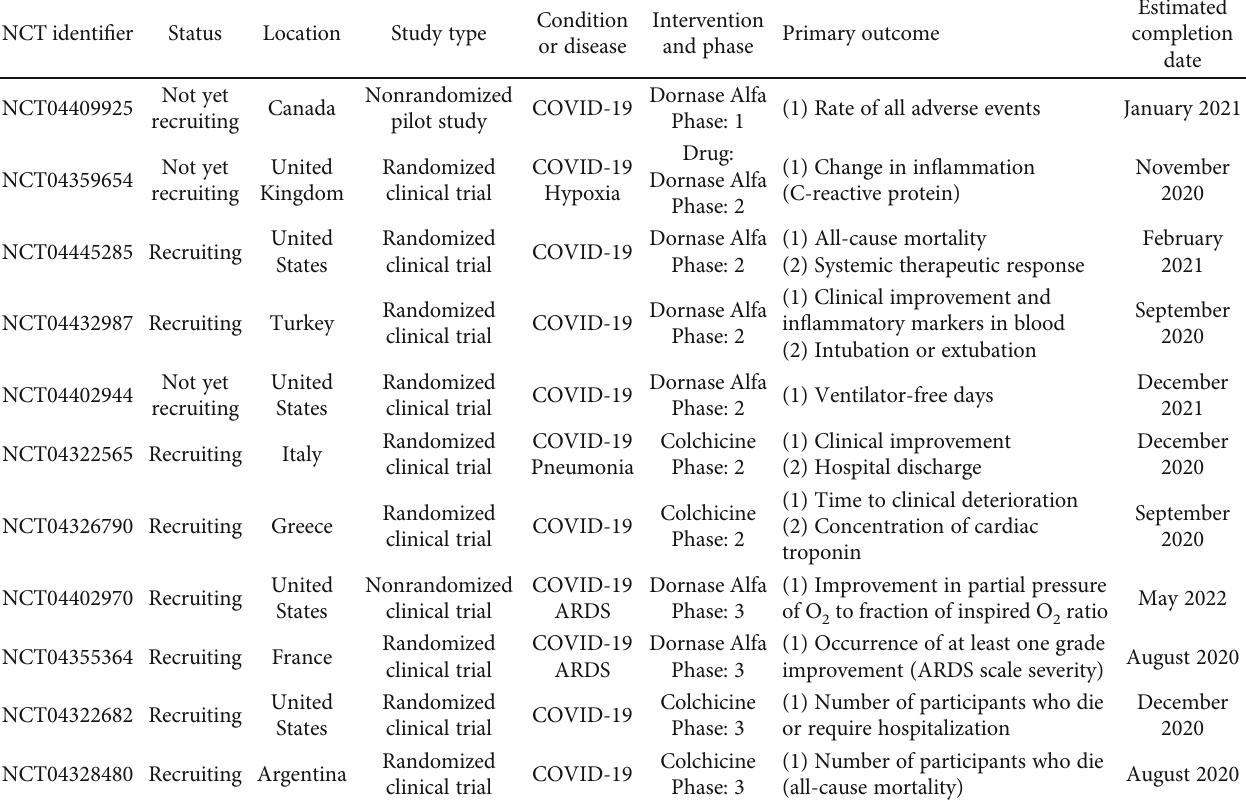
Table 1: Interventional studies registered at the ClinicalTrials.gov database relating the treatment of COVID-19 with NET inhibitors. NCT identi fi